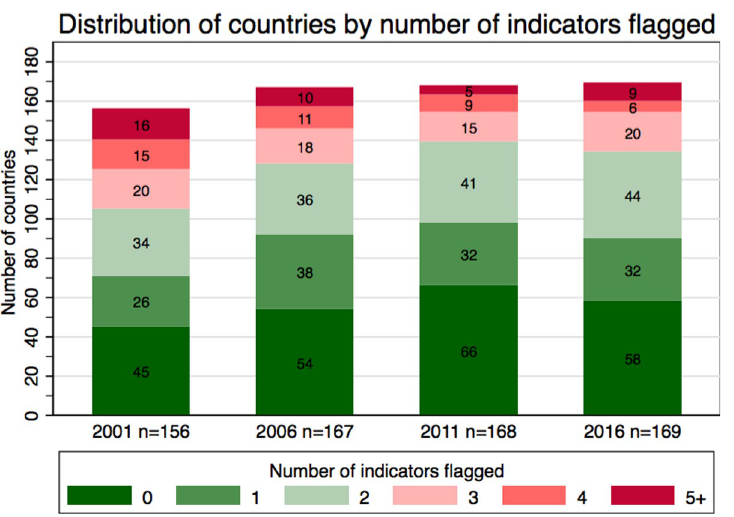
Fig 4. Distribution of countries by number of denominator consistency and accuracy indicators flagged over